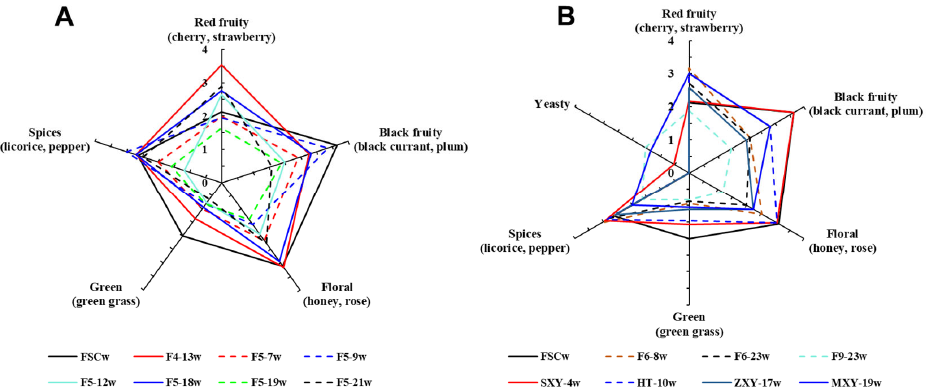
Figure 7. Aroma sensory evaluation of wines fermented by the selected S. cerevisiae strains ( A ): sensory evaluation of FSCw, F4-13w, F5-7w, F5-9w, F5-12w, F5-18w, F5-19w, and F5-21w; ( B ): sensory evaluation of FSCw, F6-8w, F6-23w, F9-23w, SXY-4w, HT-10w, ZXY-17w, and MXY-19w).